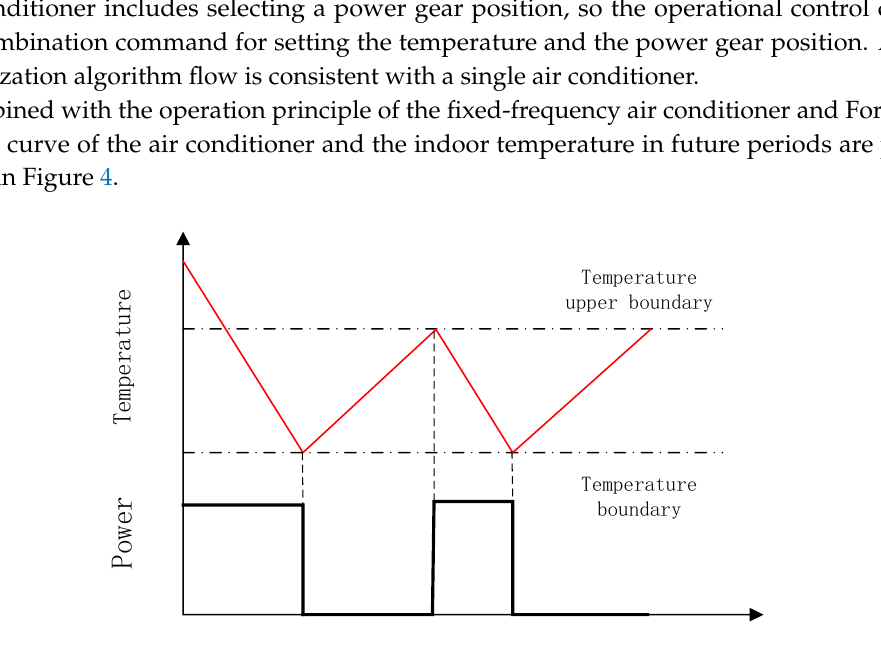
Figure 4. Running a dynamic process diagram for a fixed-frequency air conditioner.